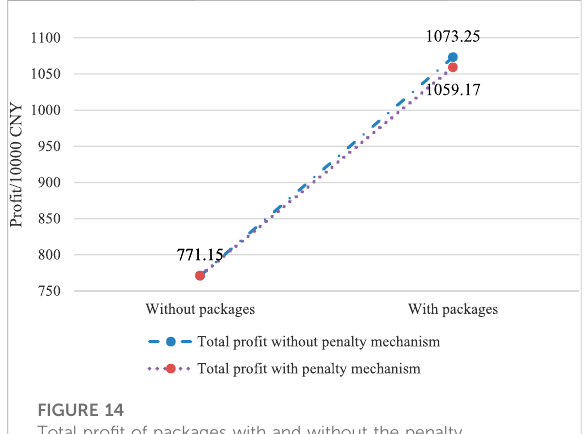
FIGURE 14 Total pro fi t of packages with and without the penalty